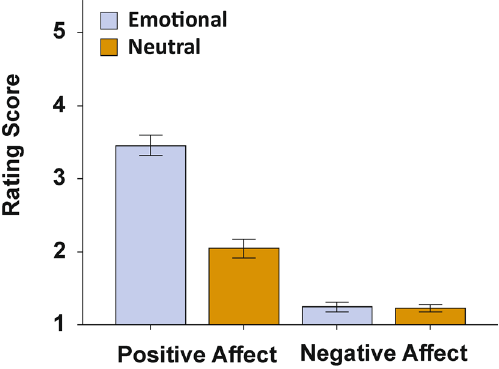
Figure 2. PANAS ratings indicating the momentary emotional state following the emotional or the neutral experimental condition. Error bars represent